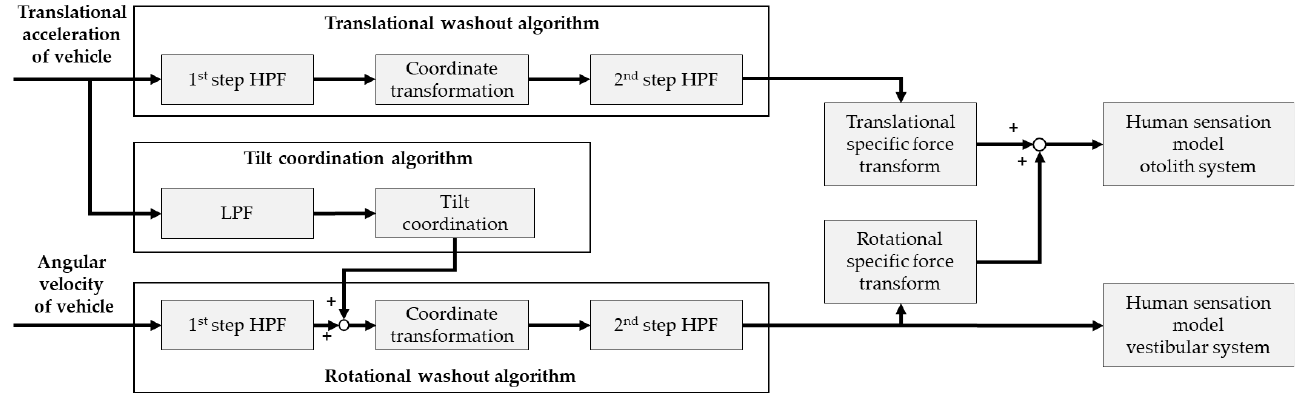
Figure 12. Simulation diagram for the motion sensation by the classical washout algorithm.